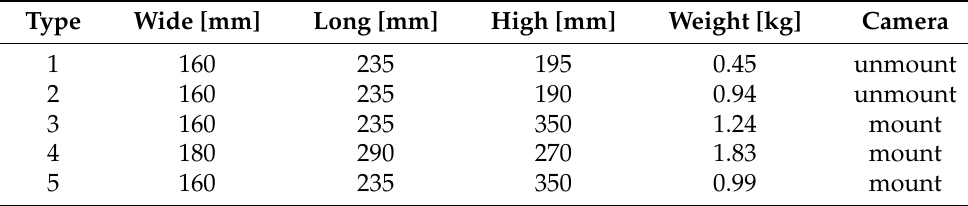
Table 3. Major specifications of originally developed sensor brackets of four types.